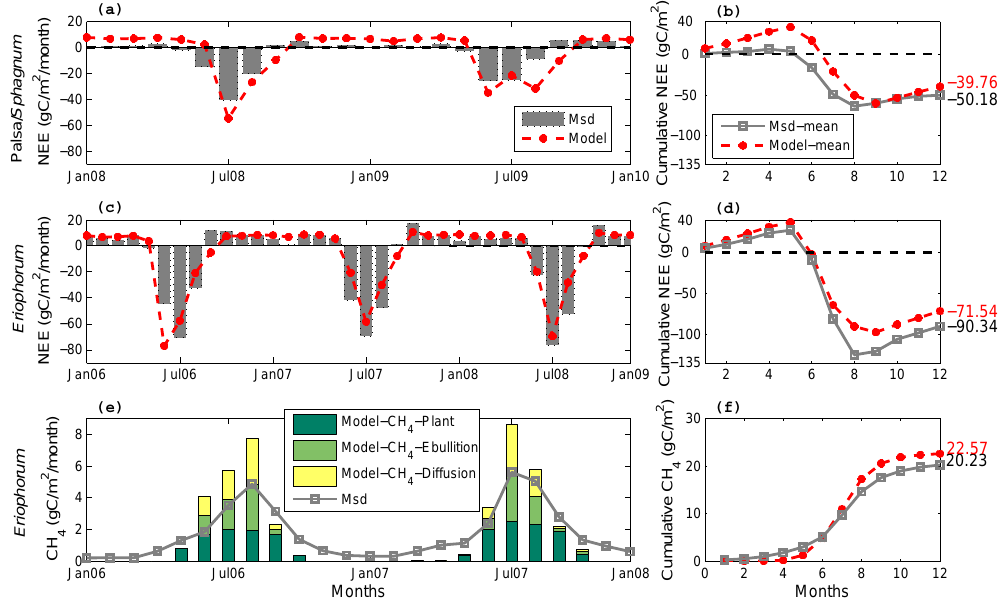
Figure 3. Monthly (left) and mean annual cumulative (right) CO 2 NEE and CH 4 fluxes for the peatland. Positive values indicate ecosystem release to the atmosphere and negative values indicate ecosystem uptake. Msd stands for